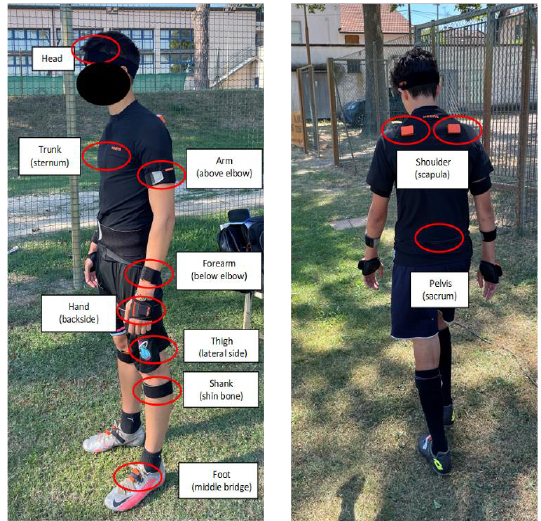
Figure 3. Sensor placement—bilaterally on feet (middle bridge); shanks (shin bone); thighs (lateral side); shoulders (scapulae); arms (lateral above elbow); forearms (lateral below elbow); hands (backside); pelvis (sacrum); trunk (sternum);